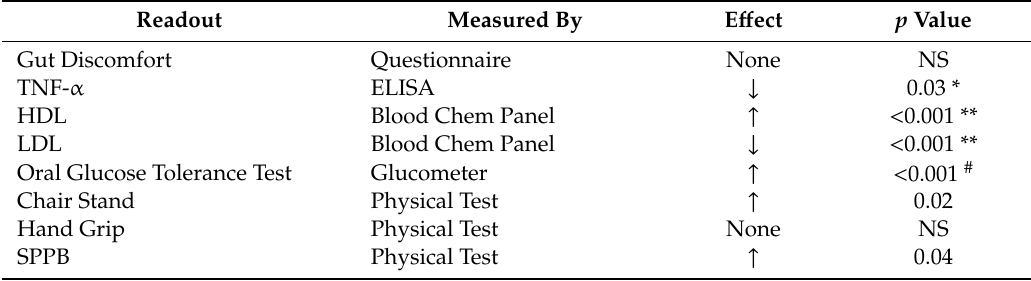
Table 2. Summary of main readouts from Trial NCT04450979 and associated significance of e ff ects